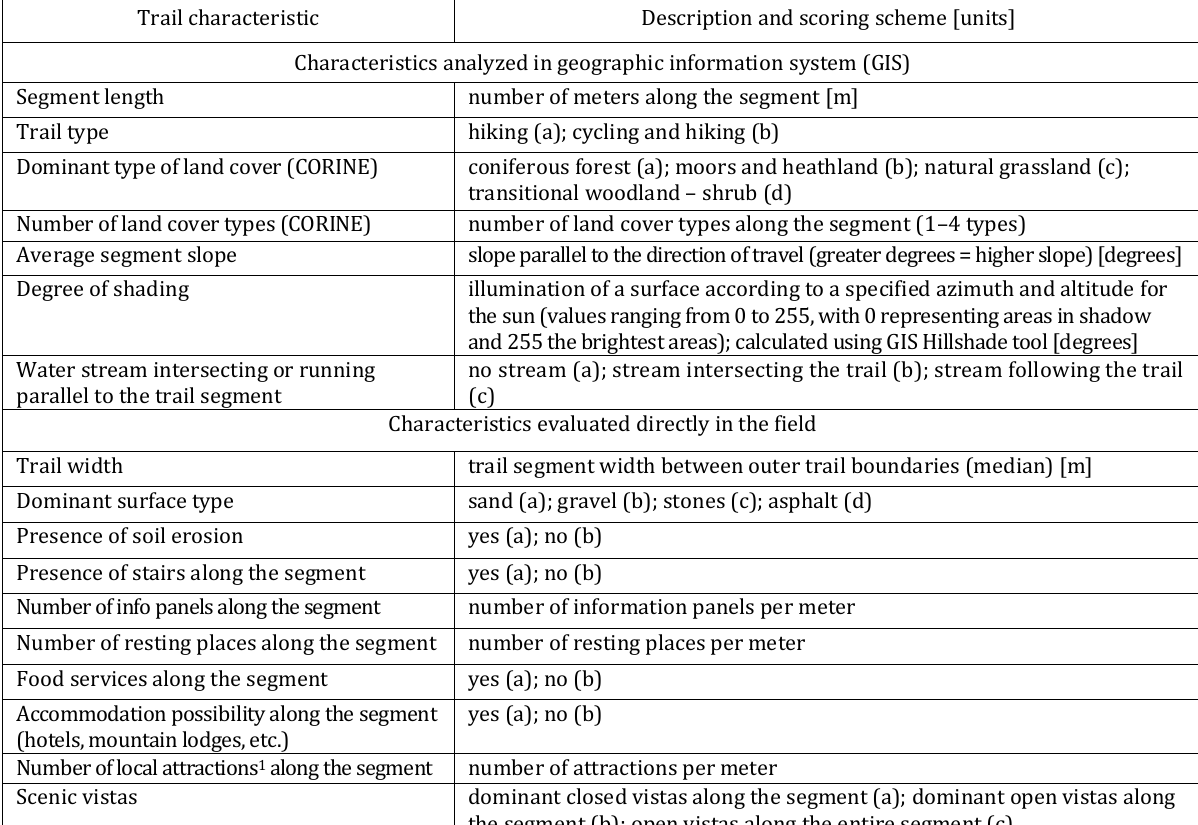
Table 1. Surveyed and analysed trail segment characteristics Description and scoring scheme